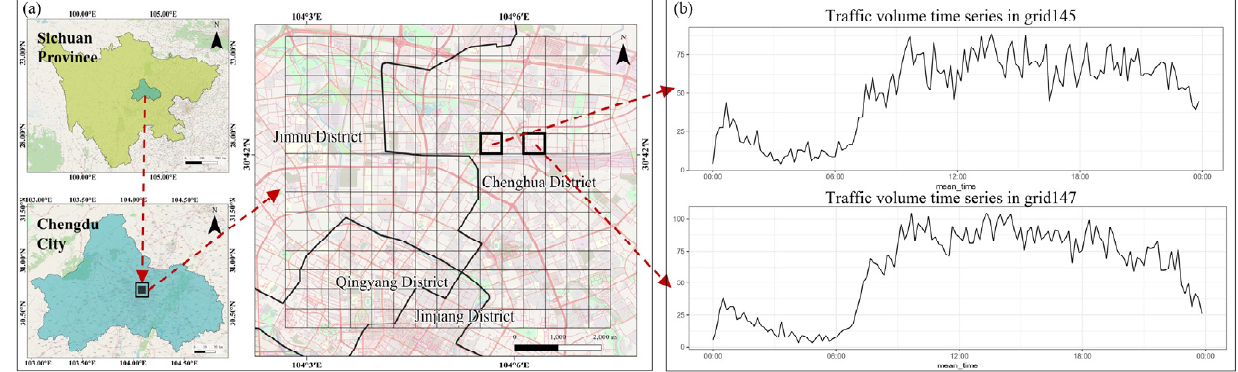
Figure 3. Study area and example of traffic volume time series. ( a ) Case study area in Chengdu, Sichuan province. ( b ) Traffic volume time series in grid145 and grid147.